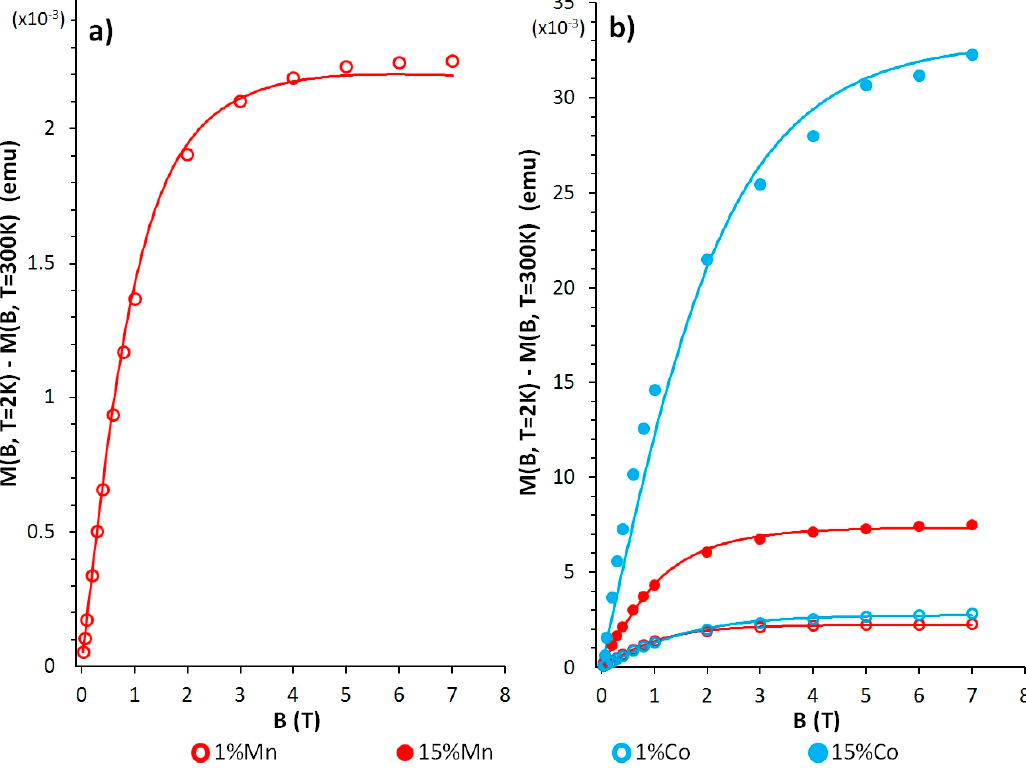
Figure 11. Magnetisation difference M exp (B, T = 2 K)—M exp (B, T = 300 K) as a function of the magnetic field for: ( a ) Zn 0.99 Mn 0.01 O, solid line: fit with Equations (5) and (6); T 0 was set to 0 K; ( b ) Zn 0.99 Mn 0.01 O and Zn 0.85 Mn 0.15 O (red), solid lines: fits with Equations (5) and (6), with S = 5/2 and T 0 as an adjustable parameter (T 0 = − 0.17 K for Zn 0.99 Mn 0.01 O and T 0 = − 0.29 K for Zn 0.85 Mn 0.15 O sample), Zn 0.99 Co 0.01 O and Zn 0.85 Co 0.15 O (blue), solid lines: fits with Equations (5) and (6), with S = 3/2 and T 0 as an adjustable parameter (T 0 = − 0.24 K for Zn 0.99 Co 0.01 O and T 0 = − 0.95 K for Zn 0.85 Co 0.15 O sample).